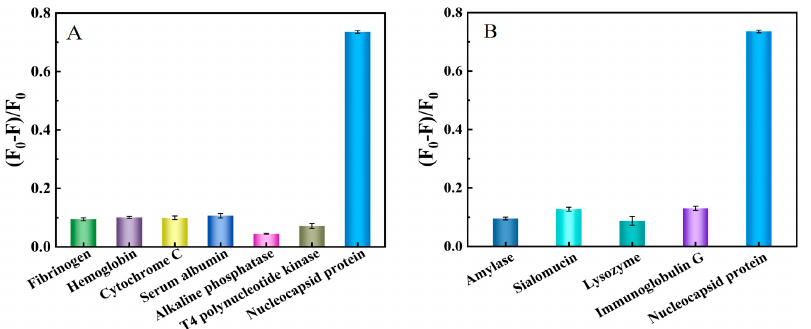
Figure 7. (F 0 − F)/F 0 value of potential interferences in human blood samples ( A ) and throat swabs ( B ). The concentration of potential interferences or N protein was all set at 600 nM. We also selected four proteins (amylase, sialomucin, lysozyme, immunoglobulin G) usually discovered in saliva as potential interferences for selective experiments. Figure 7B showed (F 0 − F)/F 0 of the system when potential interferences or N protein were added into the system with a final concentration of 600 nM. Compared with (F 0 − F)/F 0 by more than 0.7 in addition to N protein, (F 0 − F)/F 0 of the system in the case of amylase, sialo- mucin, lysozyme, immunoglobulin G accounted for only 0.096, 0.127, 0.088, and 0.131, respectively. These results proved the high selectivity of our proposed method and showed the application prospect in serum and saliva sample detection.